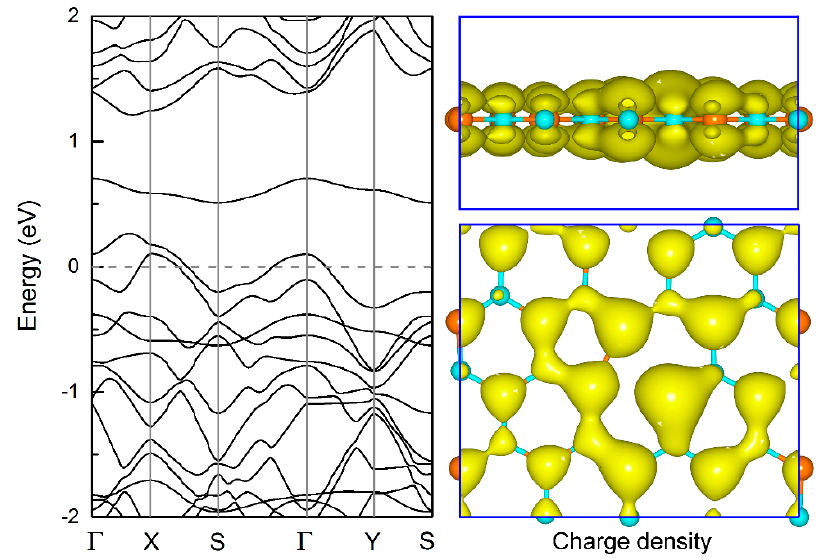
Figure 4. Electronic band structure and spatial charge density of the B_v defective boron-phosphide monolayer. The isosurface of charge density is set to 0.02 e ·Å − 3 .